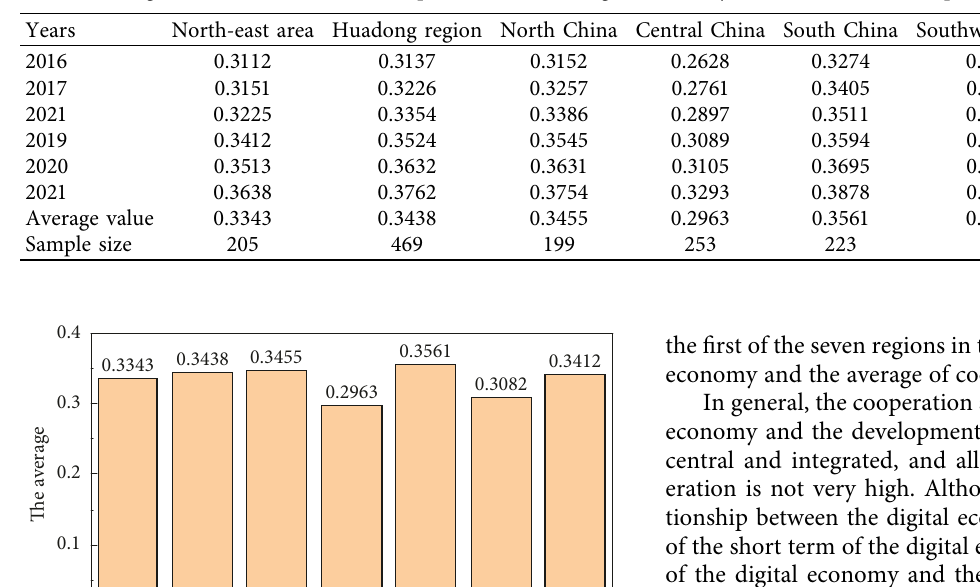
Table 4: Degree of collaboration and cooperation between digital economy and sustainable development in seven regions in China.